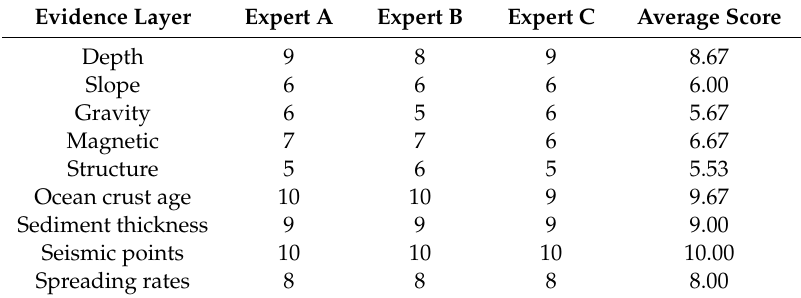
Table 1. Final scores of 9 evidential layers.